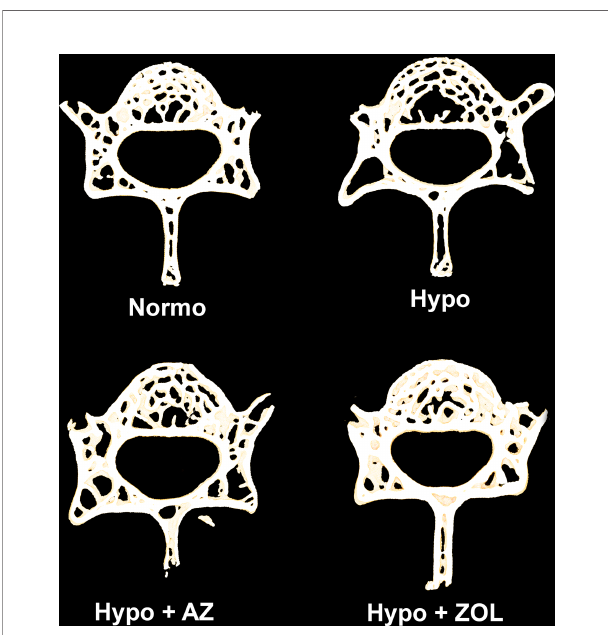
FIGURE 3 | 105- m m-thick representative horizontal sections of the L4 vertebral body from mice housed at normobaric pressure (Normo) or exposed to hypobaric pressure (Hypo) at 500 mbar for four weeks and treated with acetazolamide (AZ) or zoledronate (ZOL). Treatment with ZOL signi fi cantly increased vertebral bone volume fraction (BV/TV) compared with